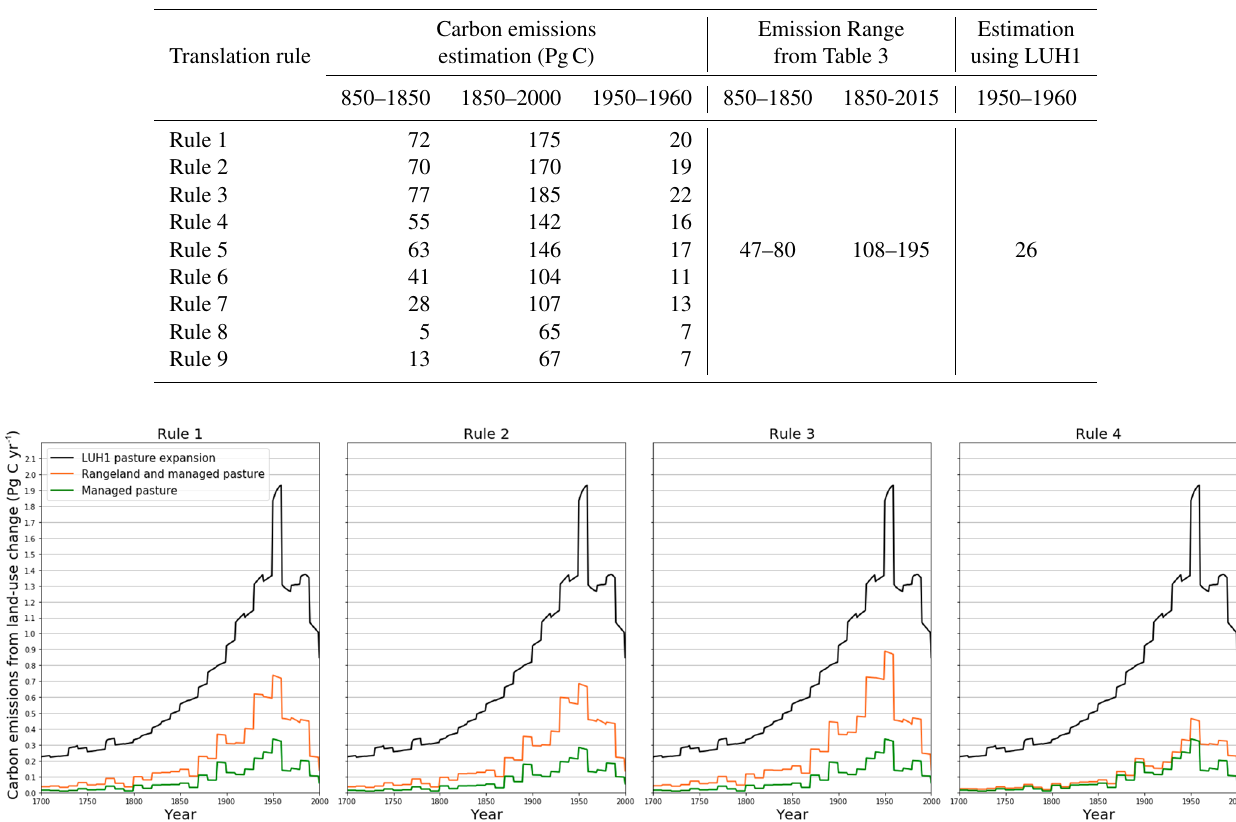
Figure 5. Carbon emissions due to vegetation (forest and non-forest) removal in expansion of managed pasture and rangeland. Black line represents emissions from pasture expansion in LUH1. Orange and green lines represent emissions from expansion of managed pasture and rangeland and from expansion of just managed pasture, respectively, in LUH2. Note that the pasture category in LUH1 corresponds to managed pasture and rangeland together in